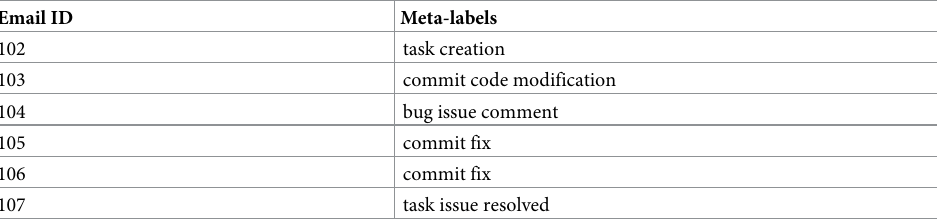
Table 3. Consensus meta-labels for emails 102-107 following the Delphi process